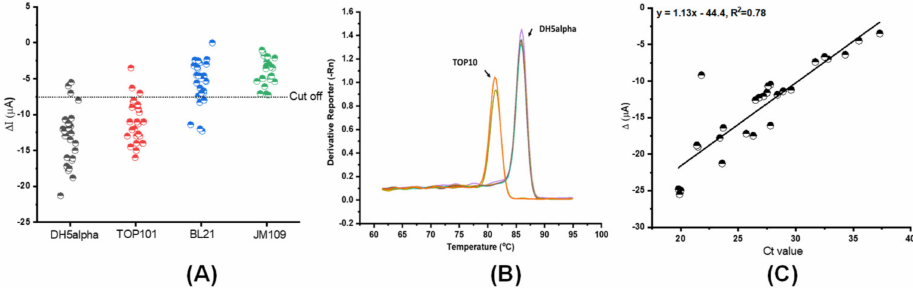
Figure 6. ( A ) Evaluation of cross-reactive E. coli DH5alpha antibodies to TOP10, BL21, and JM109 species of E. coli . The cut-off value was obtained from the Receiver Operating Characteristics (ROC) Curve (not shown). ( B ) Melting curves for specific amplification analysis. ( C ) Biosensing measurements of E. coli DH5alpha compared with colony qPCR by a regression